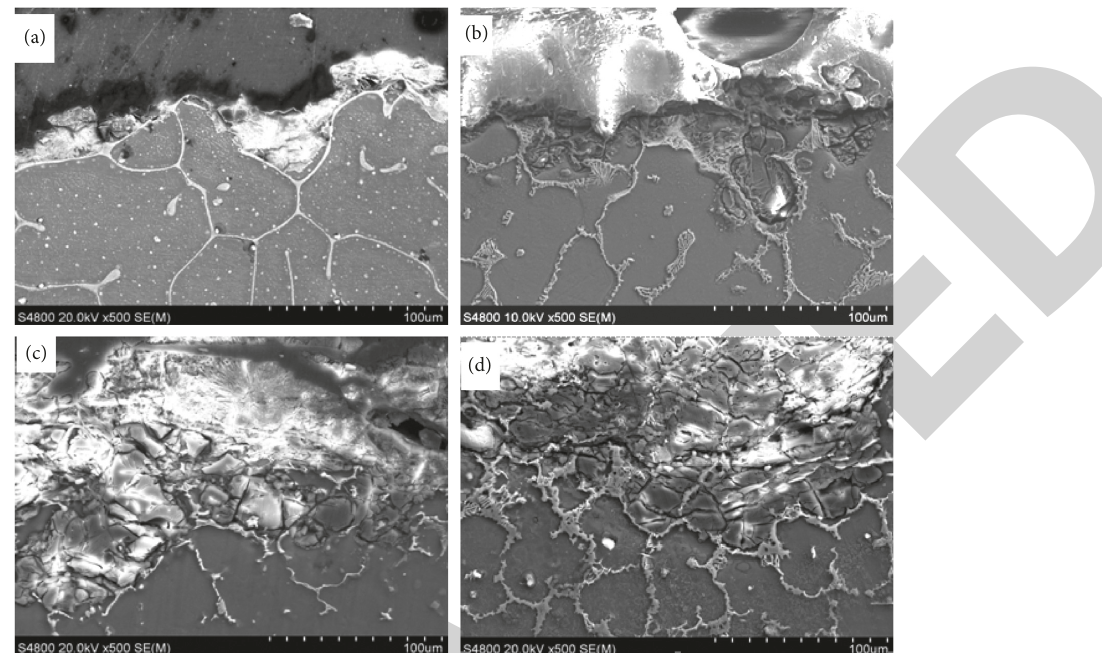
Figure 5: Cross-sectional SEM images of the as-cast (a) AC02 alloy immersed for 2h, (b) AC32 alloy immersed for 4h, (c) AC52 alloy immersed for 4h, and (d) AC92 alloy immersed for 13h in 3.5% NaCl